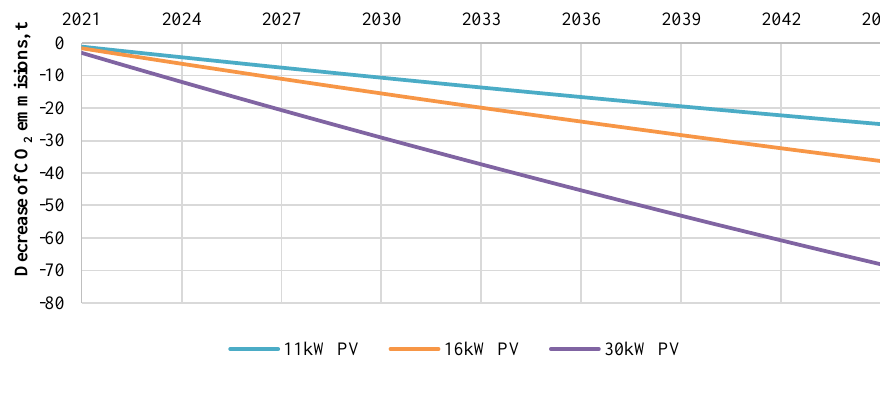
Fig. 5. Decrease of CO 2